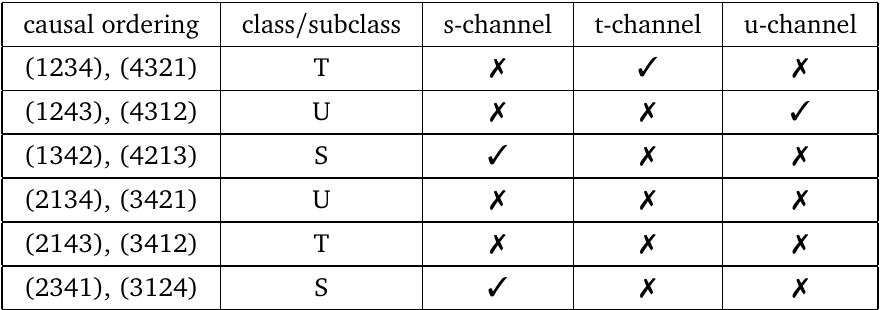
Table 11: OPE convergence properties of type 7 causal